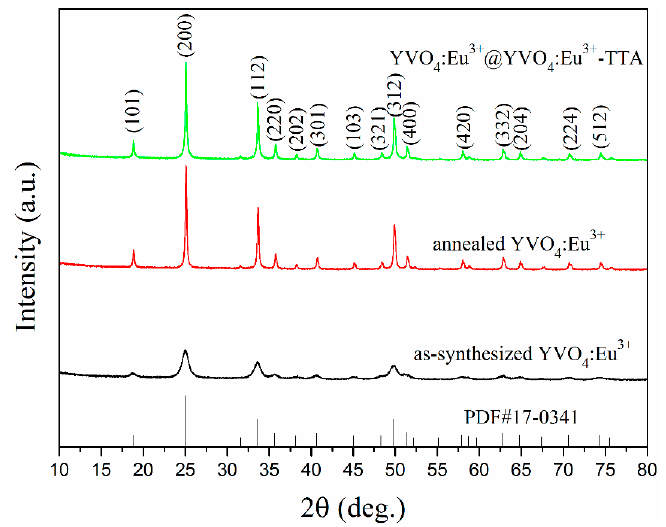
+ , the annealed YVO 3 + 4 :Eu